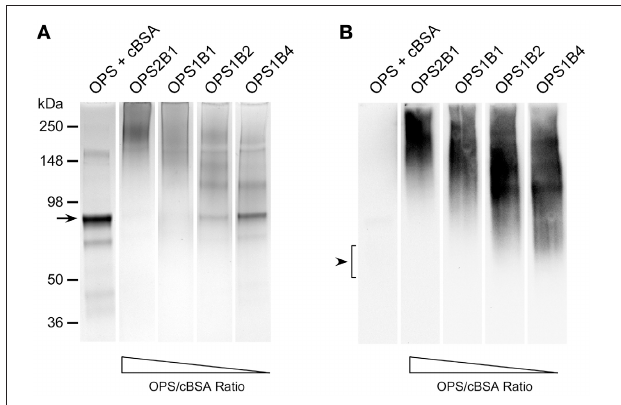
FIGURE 3 | Physical analysis of B. thailandensis OPS-cBSA glycoconjugates. (A) SDS-PAGE and Coomassie Blue staining was used to confirm the covalent linkage of ZT0715 OPS to cBSA. The OPS + cBSA lane represents unconjugated controls. The black arrow indicates the position of the predominant cBSA band. The positions of protein molecular size standards are indicated on the left. (B) Western immunoblotting was also used to assess the antigenicity of the chemically activated/coupled ZT0715 OPS. OPS was detected using the 3D11mAb. Lanes were loaded with similar amounts of protein or carbohydrate to facilitate direct comparisons. The black arrowhead indicates the position of the OPS which binds poorly to the membrane when unconjugated.